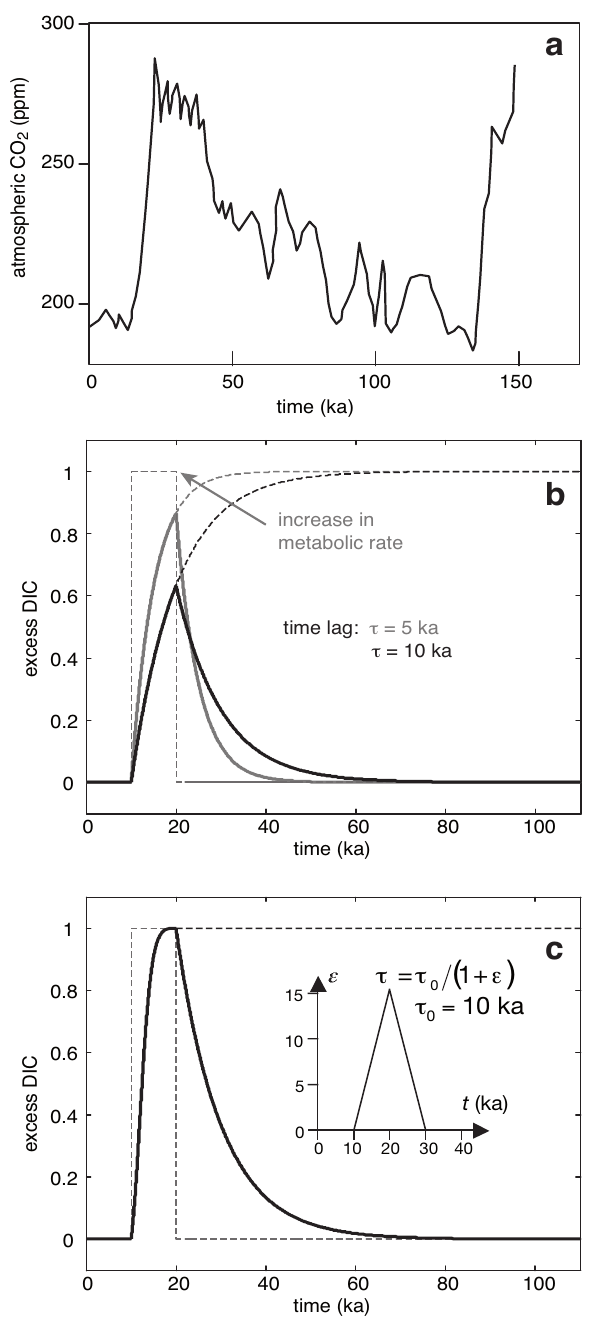
Fig . 6. – (a) atmospheric Co changes during the last 150 ka, as 2 deduced from the vostok ice cores from antarctica, illustrating the rapid increase during interglacial periods followed by a slow de- crease during the subsequent glacial period. adapted from petit et al . (1999). panels (b) and (c) show the model prediction for changes in DIC in a constant-volume upper ocean (depth about 1300 m) as a result of a step-like increase in the forcing concentration from c to 0 ( c + c ) during [ t = 10 ka, t = 20 ka]. The c value is normalised 0 1 0 1 1 to one. (b) solution for constant systemic recirculation rates, Q = 0 1.5 and 3.0 sv, that correspond to advective times τ = 10 and 5 ka, 0 respectively. (c) solution for a non-constant recirculation rate Q (1 0 + ε ), with Q = 1.5 sv ( τ = 10 ka) and ε ( t ) increasing linearly from 0 0 0 to 15 during [ t = 10 ka, t = 20 ka], and then decreasing at the same 0 1 rate during [ t = 20 ka, t = 30 1 2